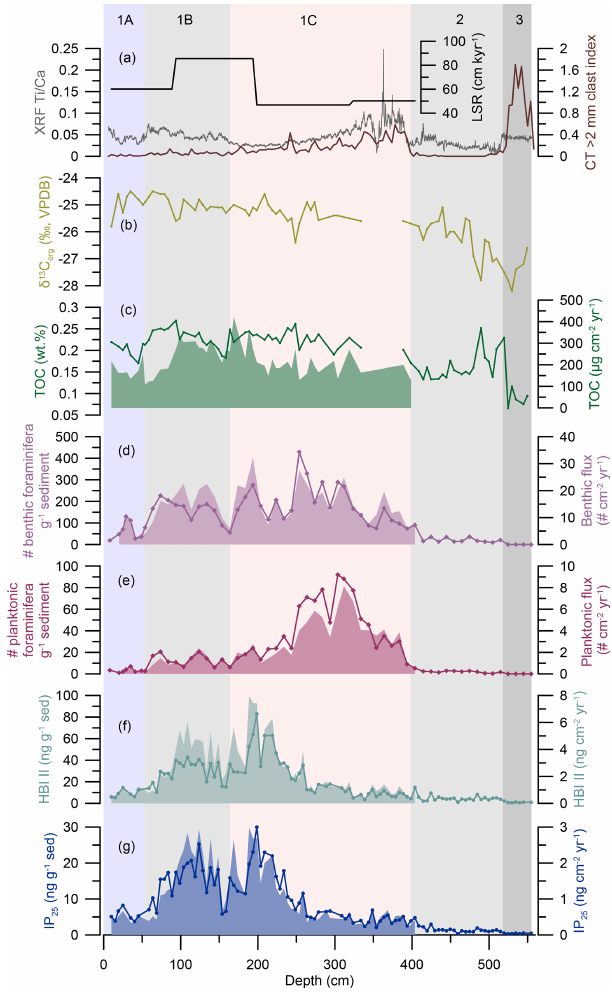
Figure 3. HBI biomarker, TOC, and foraminiferal results from OD1507-03TC-41GC-03PC. From the top to the bottom: (a) linear sedimentation rates (LSR; black), the XRF Ti / Ca ratio (grey), and the CT > 2mm clast index (brown) (Reilly et al., 2019). (b) TOC carbon isotopic values ( δ 13 C org ‰, VPDB; light green). (c) TOC fluxes (green, filled-in area) and TOC concentrations (green line). (d) Benthic foraminiferal fluxes (purple, filled-in area) and ben- thic foraminiferal abundance in individuals per gram of sediment (purple line with diamonds). (e) Planktonic foraminiferal fluxes (crimson, filled-in area) and planktonic foraminiferal abundance in individuals per gram of sediment (crimson line with diamonds). (f) HBI II fluxes (turquoise, filled-in area) and absolute concen- tration (turquoise line with dots) normalized to the amount of ex- tracted sediment (ngg − 1 sed). (g) IP 25 fluxes (blue, filled-in area) and absolute concentration (blue line with dots) normalized to the amount of extracted sediment (ngg − 1 sed). Fluxes do not extend beyond ∼ 400cm, as this depth corresponds to the lowermost avail- able radiocarbon date (Reilly et al., 2019). The vertical background fill indicates the lithological units (1A–1C, 2, 3) at OD1507-03TC- 41GC-03PC (Reilly et al.,